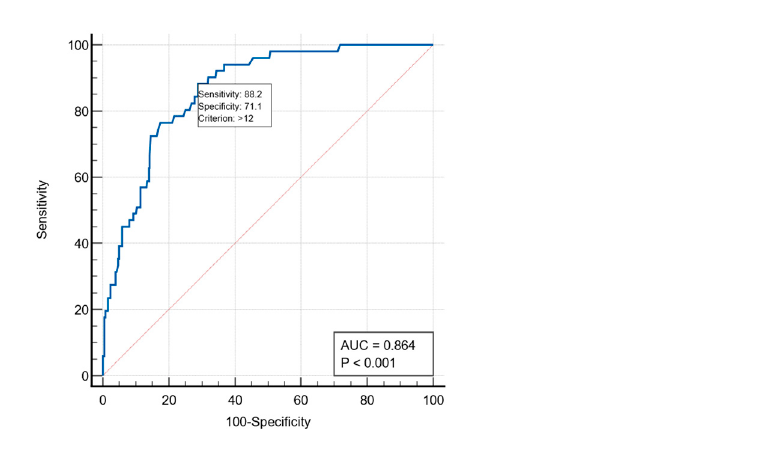
Figure 1. ROC curve—discrimination accuracy of the mortality prediction of the SRC. The SRC indicated an excellent calibration of prediction for mortality (11.80% predicted versus 11.72% observed), with the O/E ratio very close to 1 (0.993). When analyzing SRC performance in predicting postoperative mortality depending on the surgical procedure, SRC underestimated mortality in patients with PCA (6.06% versus 9.30%), PCAI (24.49% versus 28.6%), and BP (13.71% versus 14.3%) and overestimated mortality in patients with HP (13.43% versus 12.4%) and DC (17.16% versus 12.2%). The H-L test indicated a good calibration with p = 0.6422 (>0.05). The calibration graph is represented in Figure 2; the graph confirms the fit between the predicted and observed data, as the points of the graph are close to the straight line. BS was 0.080 < null model (0.103) and less than 0.25, indicating a good accuracy of the prediction.